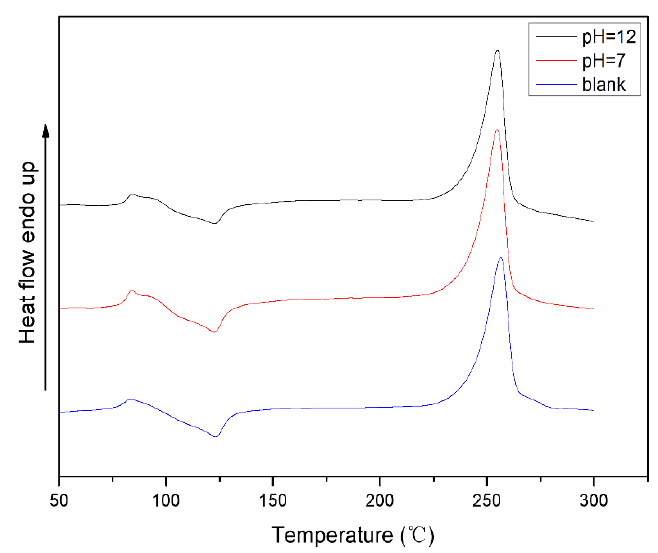
Figure 7. Thermal properties of PET substrates after whole cell biological treatment under different pH conditions.